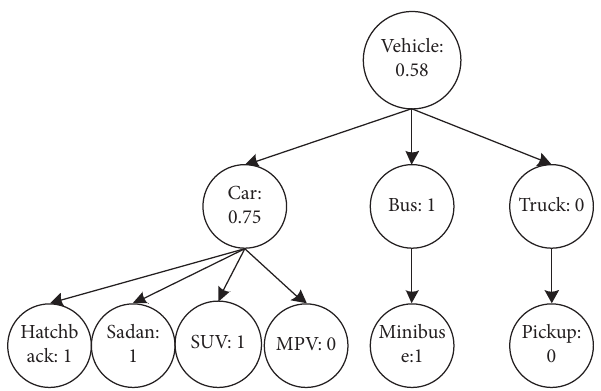
Figure 3: Semantic hierarchy tree and completeness of category of ground truth annotations for the original UTS training dataset. Table 1: Results of other quality dimensions for an